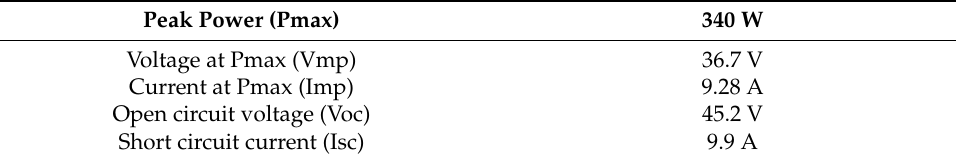
Table A1. PV panel parameters.